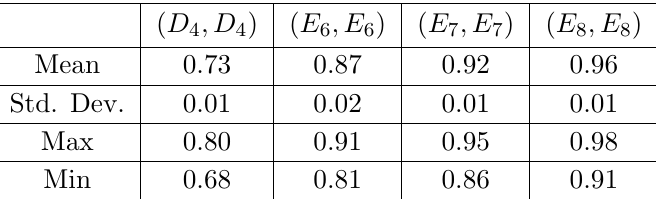
Table 7. Table of means and standard deviations for the ratio a IR =c IR across the entire nilpotent network de(cid:12)ned by (cid:13)ipper (cid:12)eld deformations of 4D conformal matter. We also display the maximum and minimum